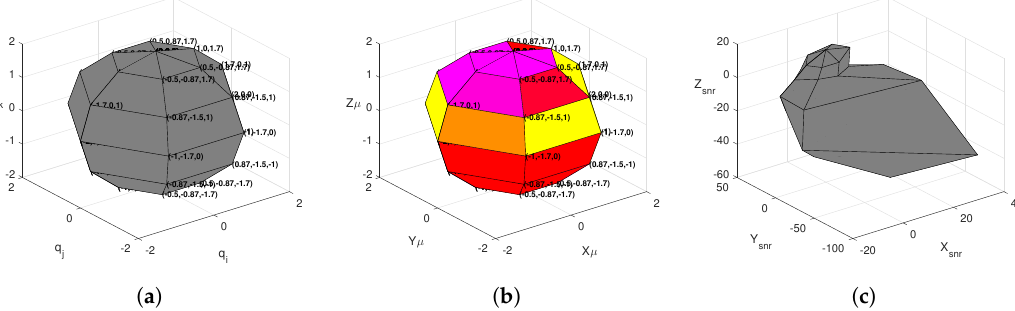
Figure 7. Supporting spheres used in the optimization of the analysis directions in QFT: ( a ) sphere of analysis directions, ( b ) sphere of calculated values for the analysis directions shown in ( a ), ( c ) sphere of SNR values for the analysis directions shown in ( a